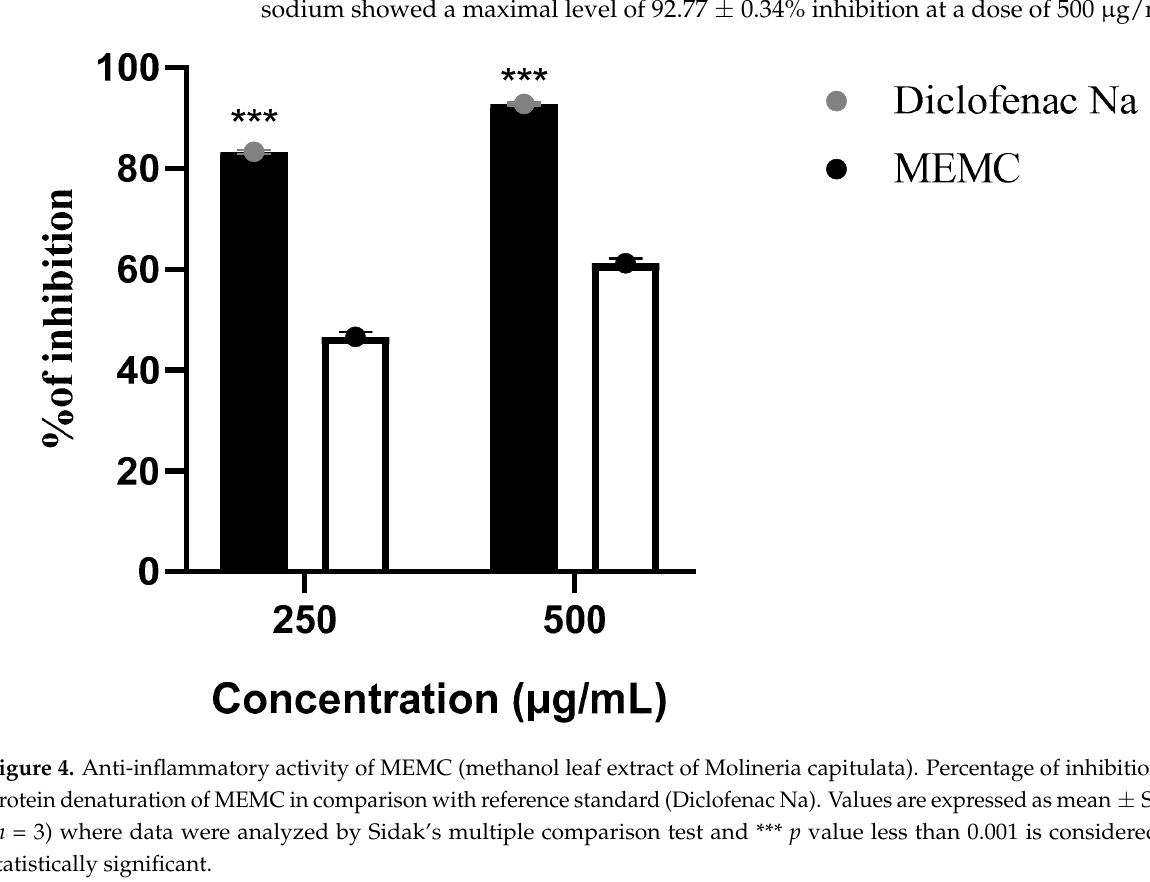
Table 3. Analgesic effect of MEMC in acetic acid induced writhing test in